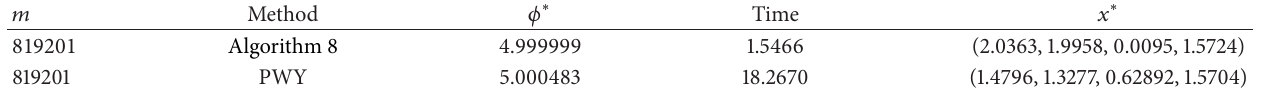
Table 3: Test results for Example 3.